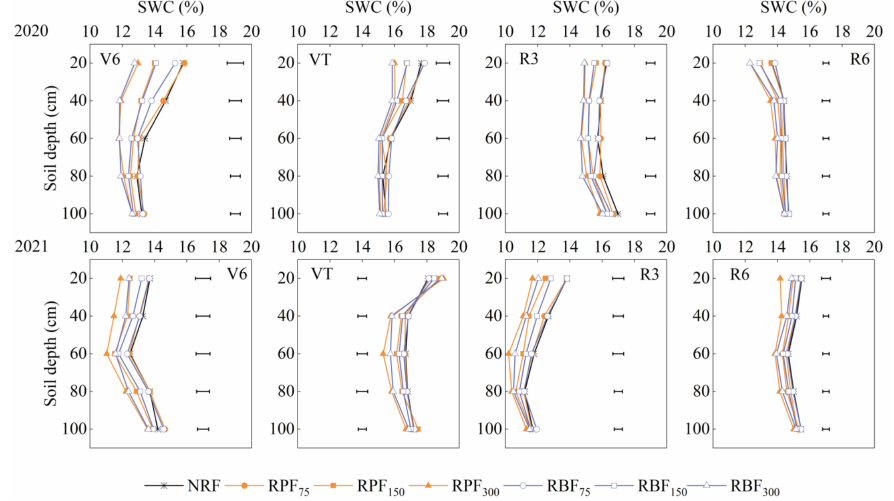
Figure 4. Dynamics of soil water content (SWC) in the 0–100 soil layer under different treatments during the spring maize growing seasons in 2020 and 2021. Horizontal bars stand for LSD at 0.05 levels. Sixth leaf stage (V6), tasseling stage (VT), filling stage (R3), and physiological maturity stage